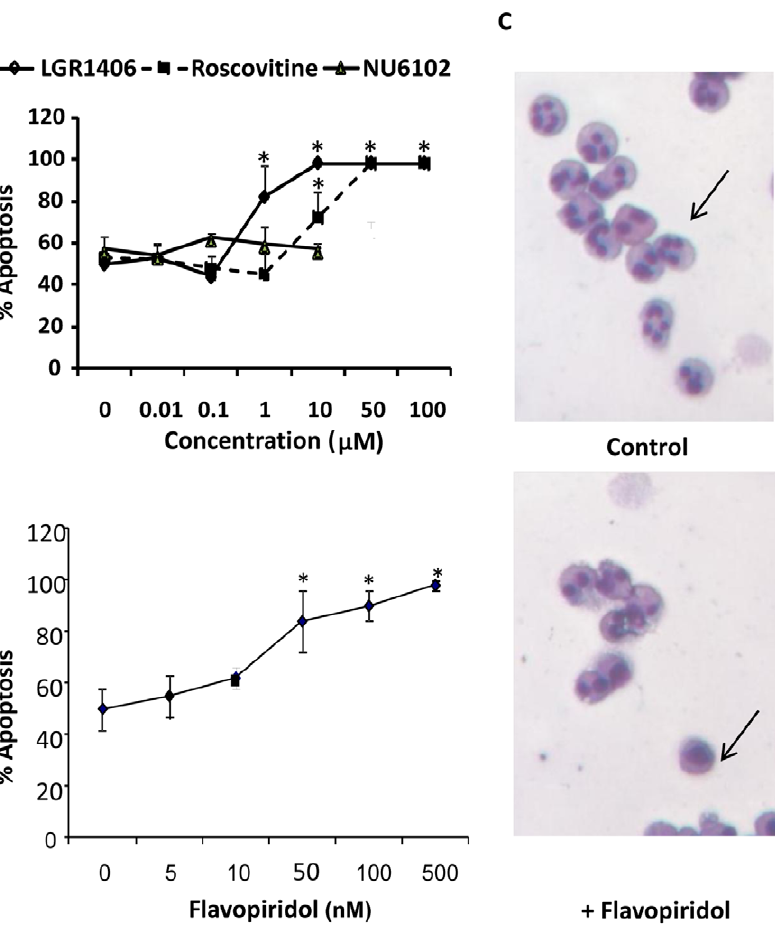
Figure 2. Inhibition of CDK9 but not cell cycle dependent CDKs increases neutrophil apoptosis. (a) Isolated human neutrophils were incubated with NU6102 (filled triangle), R-roscovitine (filled square), or LGR1406 (filled diamond) at the concentrations shown. Apoptosis was determined after 15h by assessment of DiOC 6 uptake and flow cytometry, with DiOC 6 low cells taken as apoptotic. Data are mean 6 s.d. for four separate experiments. * indicates p , 0.05 for treatment versus control. (b) Neutrophils were incubated with flavopiridol for 15 h at the concentrations shown and apoptosis determined by assessment of DiOC 6 uptake. Data are mean 6 s.d. for three separate experiments. * indicates p , 0.05 for control versus flavopiridol treated cells. (c) Images of Giemsa stained neutrophils cultured in the absence (control) or presence of 100 nM flavopiridol for 15 h.